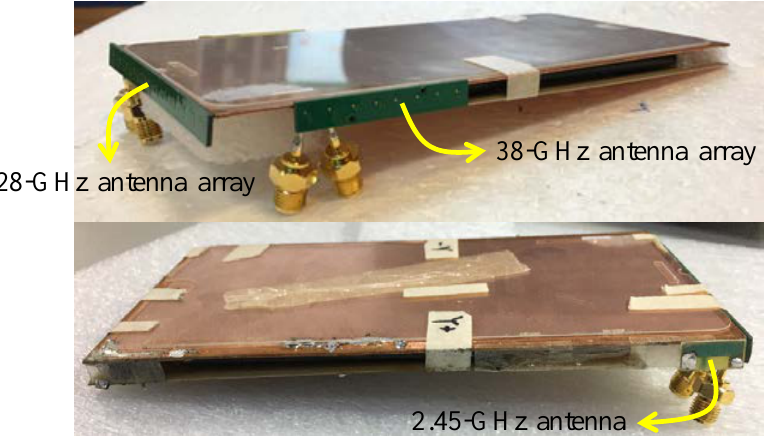
Figure 5. The prototype of the proposed antenna design and integration.